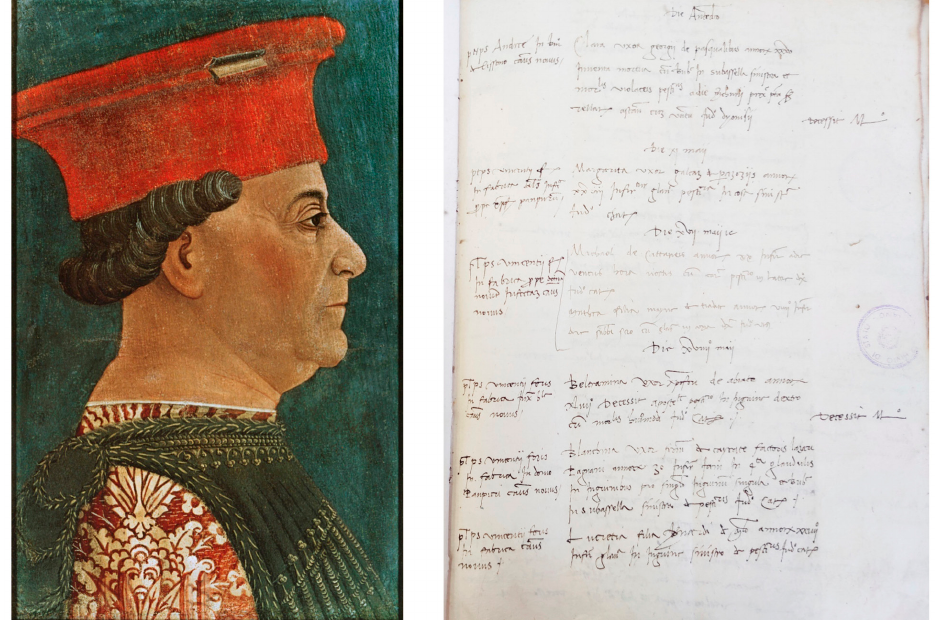
Figure 1. Francesco Sforza portrait by Bonifacio Brembo in 1460 (https://commons.wikimedia.org/wiki/File:Francesco_Sforza.jpg, accessed on 20 December 2022) and a page of the the Liber Mortuorum of 1485 (courtesy from Luca Fois).